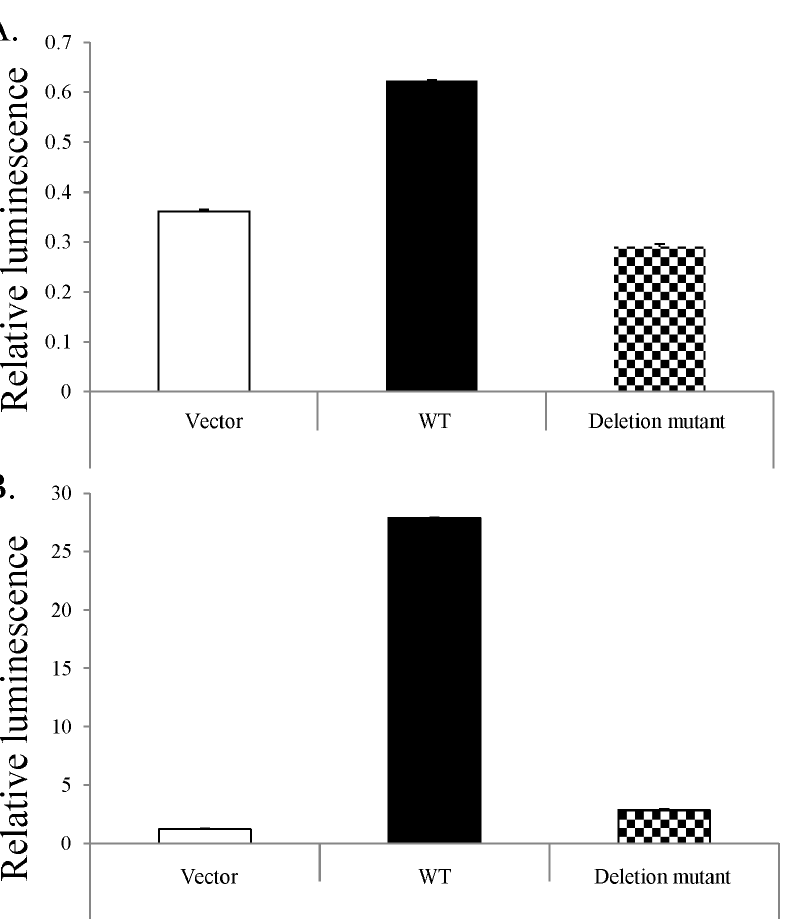
Figure 6. Novel mutation abrogates p53 binding. Cells were transfected with a plasmid containing either WT p53 or that containing the novel mutation. A. After transfection into p53 competent H460 cells, a luciferase assay shows WT p53 is capable of binding its consensus elements, whereas mutant p53 is not. B. When the same vectors were applied to naturally p53-deficient H1299 cells, this difference was much more pronounced. The sample transfected with the mutant p53 showed a small amount of luciferase activity, approximately 3 6 that of the vector, whereas the WT p53 induced 25 6 as much.